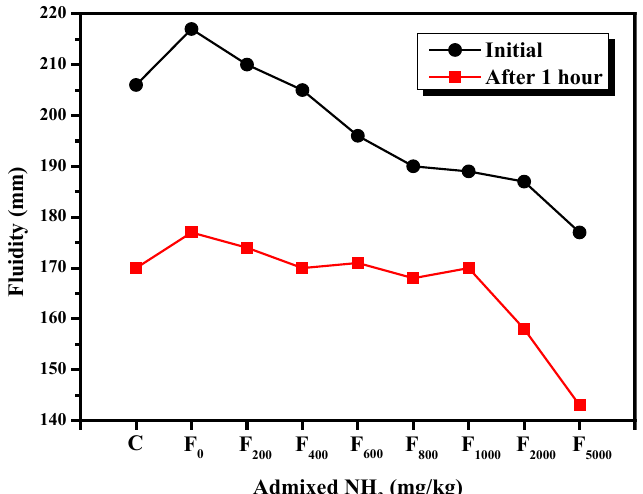
Figure 8. Changes in the fluidity of fly ash cement paste with increasing ammonia